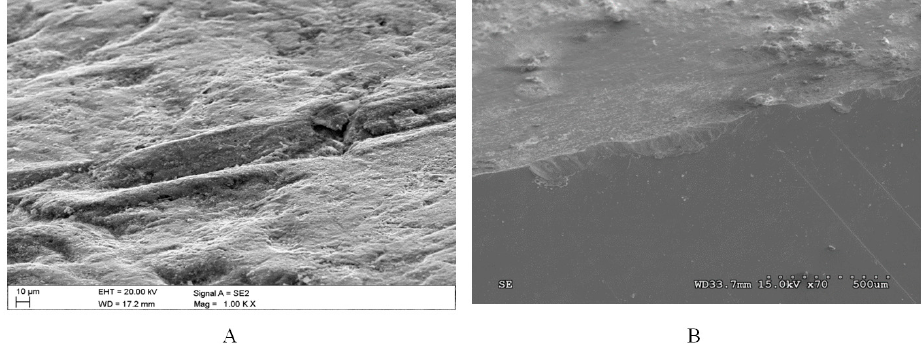
Figure 12. Damage to surfaces of the wheels caused by tribocorrosive wear, ( A )—a view of micro-cutting traces on the surface of the wheel made of the A6 cast steel (Variant C), ( B )—a view of the surface of the wheel made of the L30GS cast steel (Variant C + NaCl), SEM.